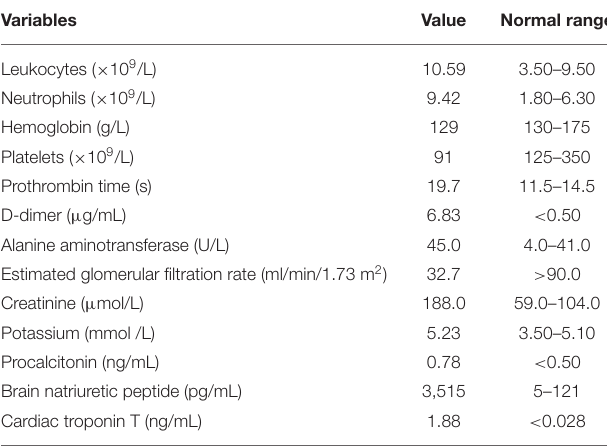
TABLE 1 | Primary blood tests of the patient on admission.